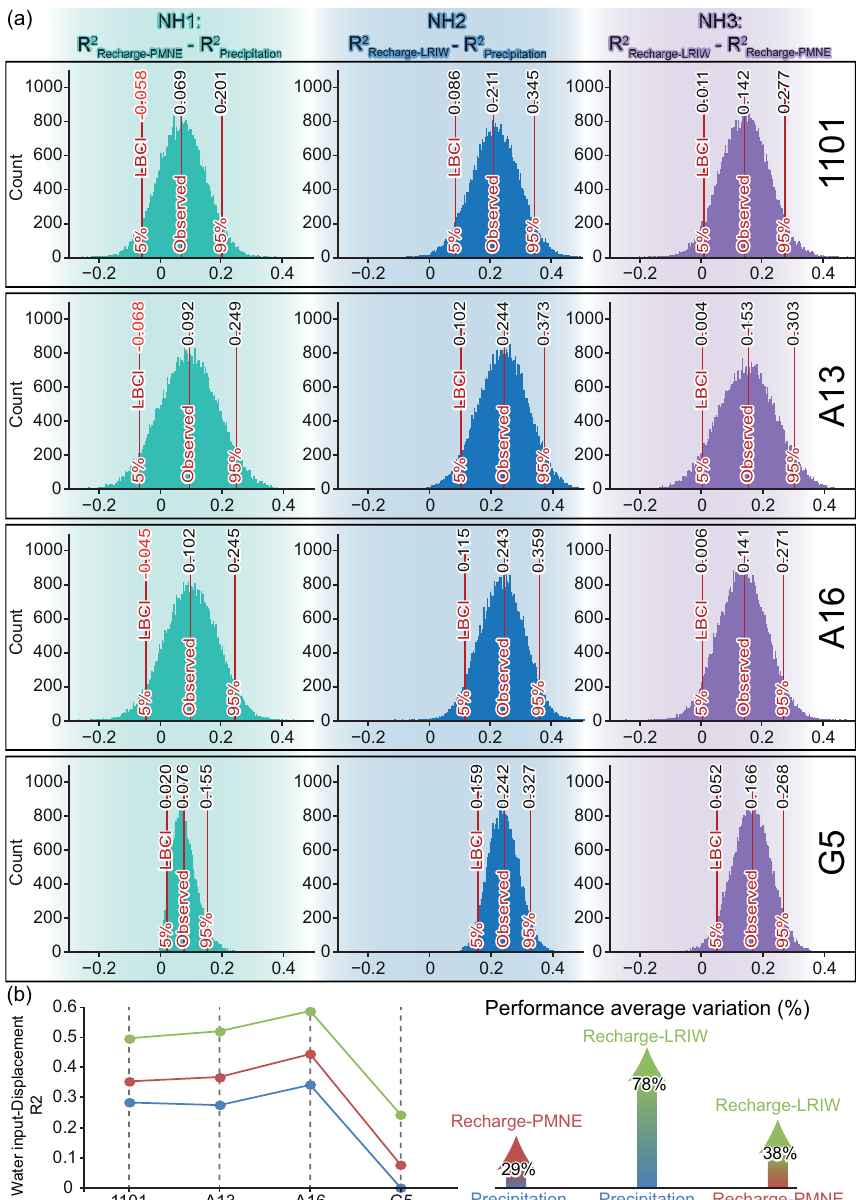
Figure 10. Performance of the LRIW workflow. (a) Bootstrap distribution of NH1, NH2 and NH3 tests for four displacement recording stations. (b) R 2 values for the four displacement recording stations obtained with the precipitation, recharge PMNE, and recharge LRIW. LBCI is the lower bound of the confidence interval. G5 station is disregarded in the the performance average variation calculation since the R 2 value obtained at G5 from precipitation is close to 0, therefore leading to a non-representative